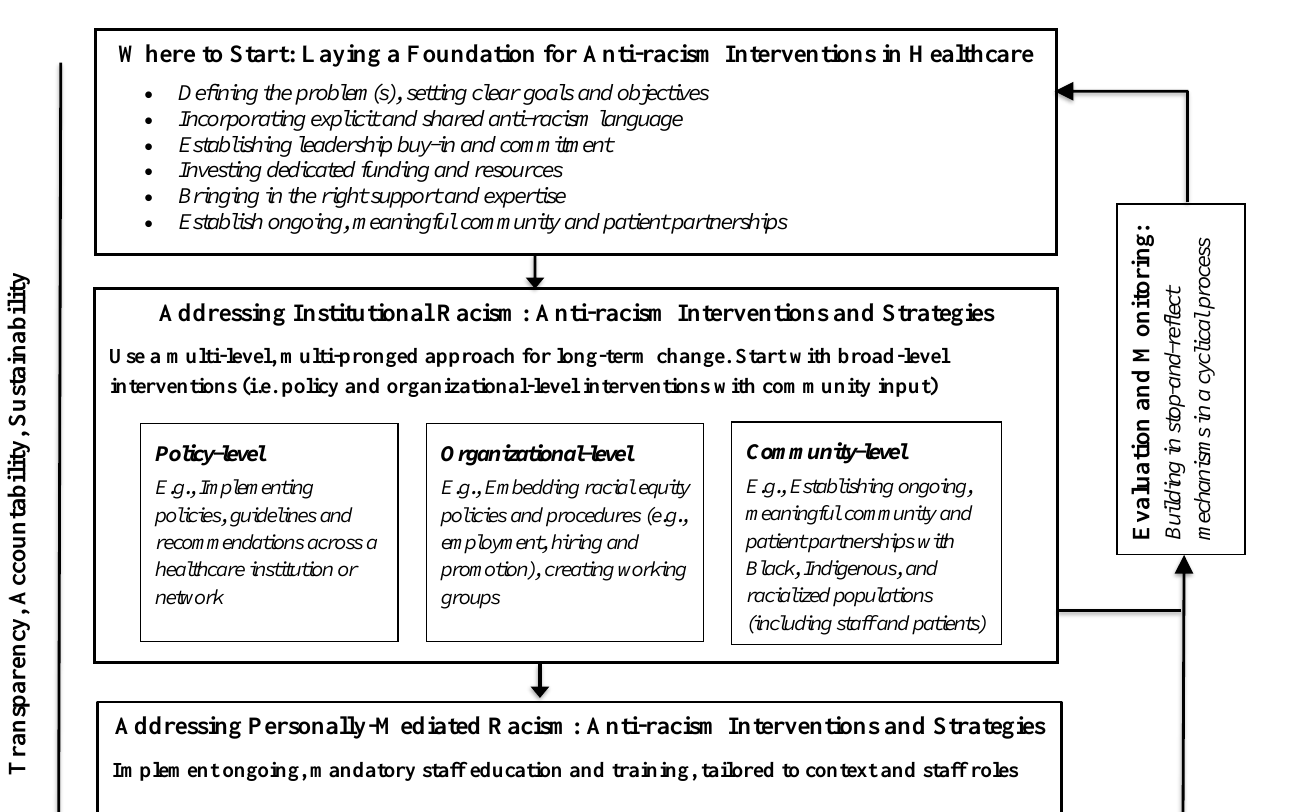
Addressing Personally-Mediated Racism: Anti-racism Interventions and Strategies Implement ongoing, mandatory staff education and training, tailored to context and staff roles